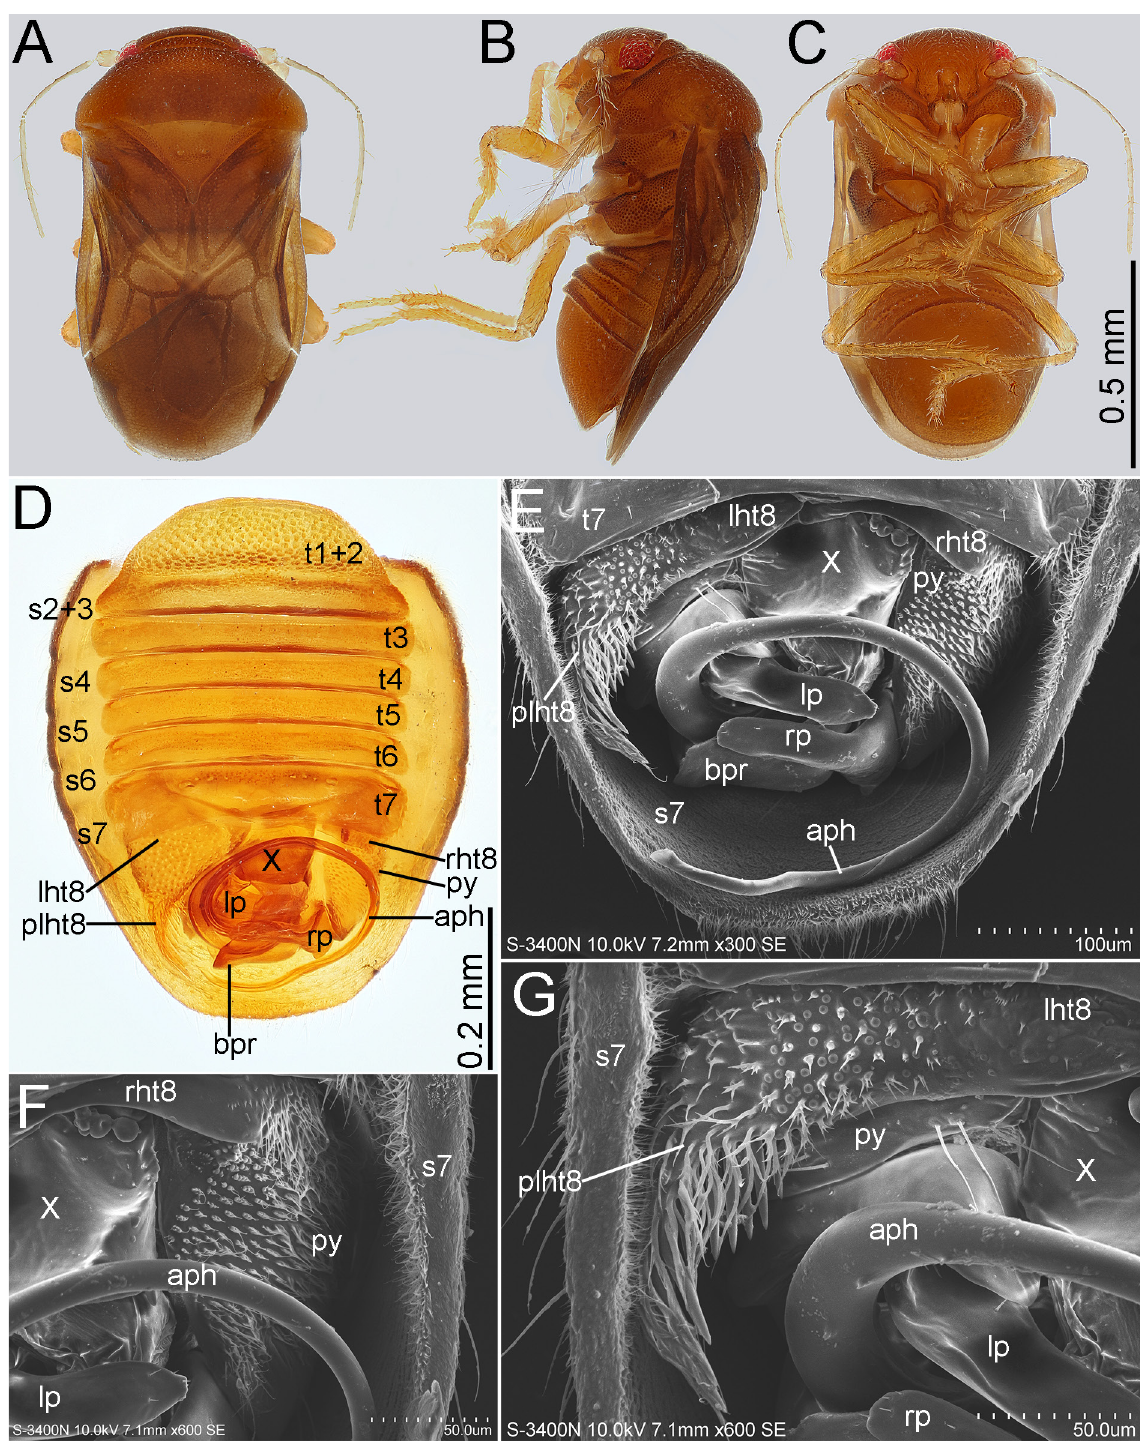
Fig. 5. Kokeshia bui sp. nov. A‒C . Habitus, holotype, ♂ (SYSBM). A . Dorsal view. B . Lateral view. C . Ventral view. D . Pregenital abdomen and genitalia, dorsal view, paratype, ♂ (SYSBM). E‒G . Scanning electron micrographs of genitalia, paratype, ♂ (SYSBM). E . Dorsal view. F . Right side, dorsal view. G . Left side, dorsal view. Abbreviations: see Material and